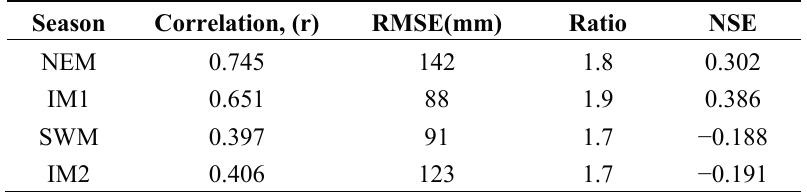
Table 1. Average annual scale statistical indicators for the direct transformed Tropical Rainfall Measuring Mission (TRMM) 3B43 data for average Peninsular Malaysia from 1998 to